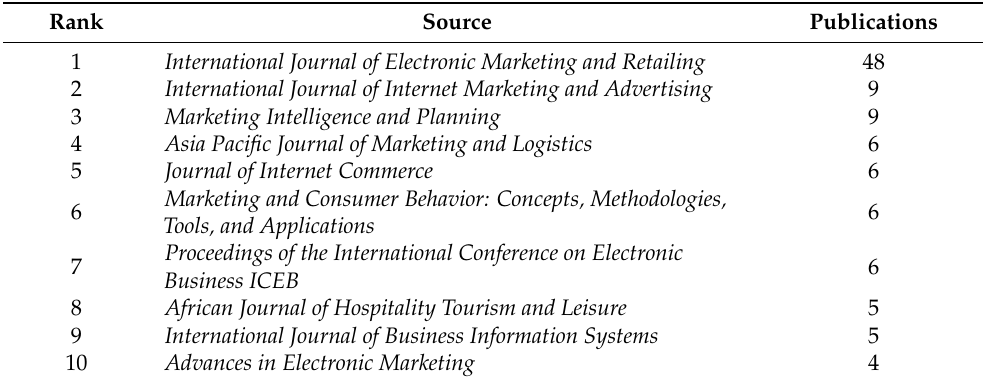
Table 4. Top ten sources that published electronic marketing